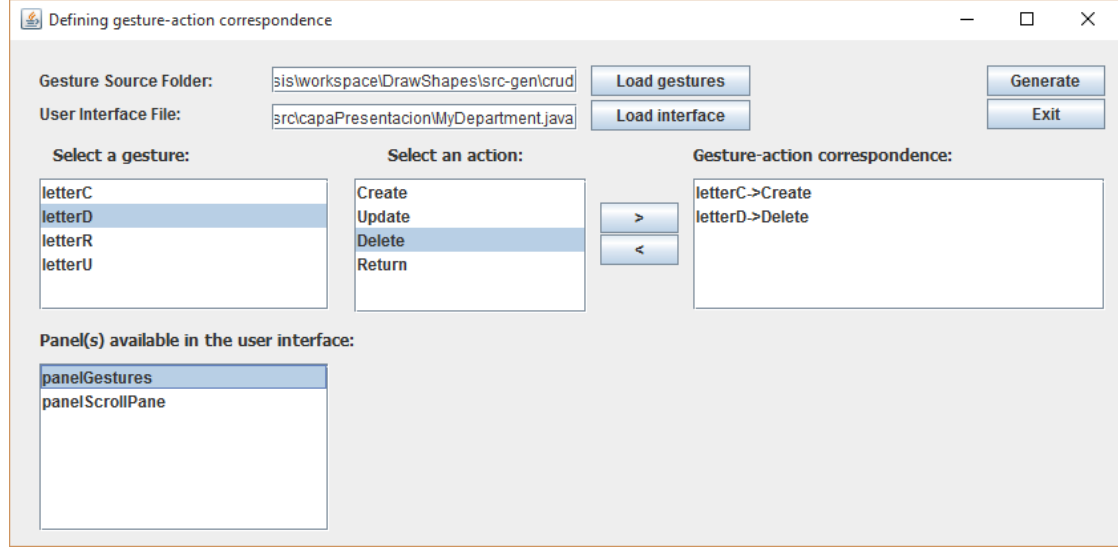
Figure 10. Interface for defining gesture-action correspondence and to generate source code